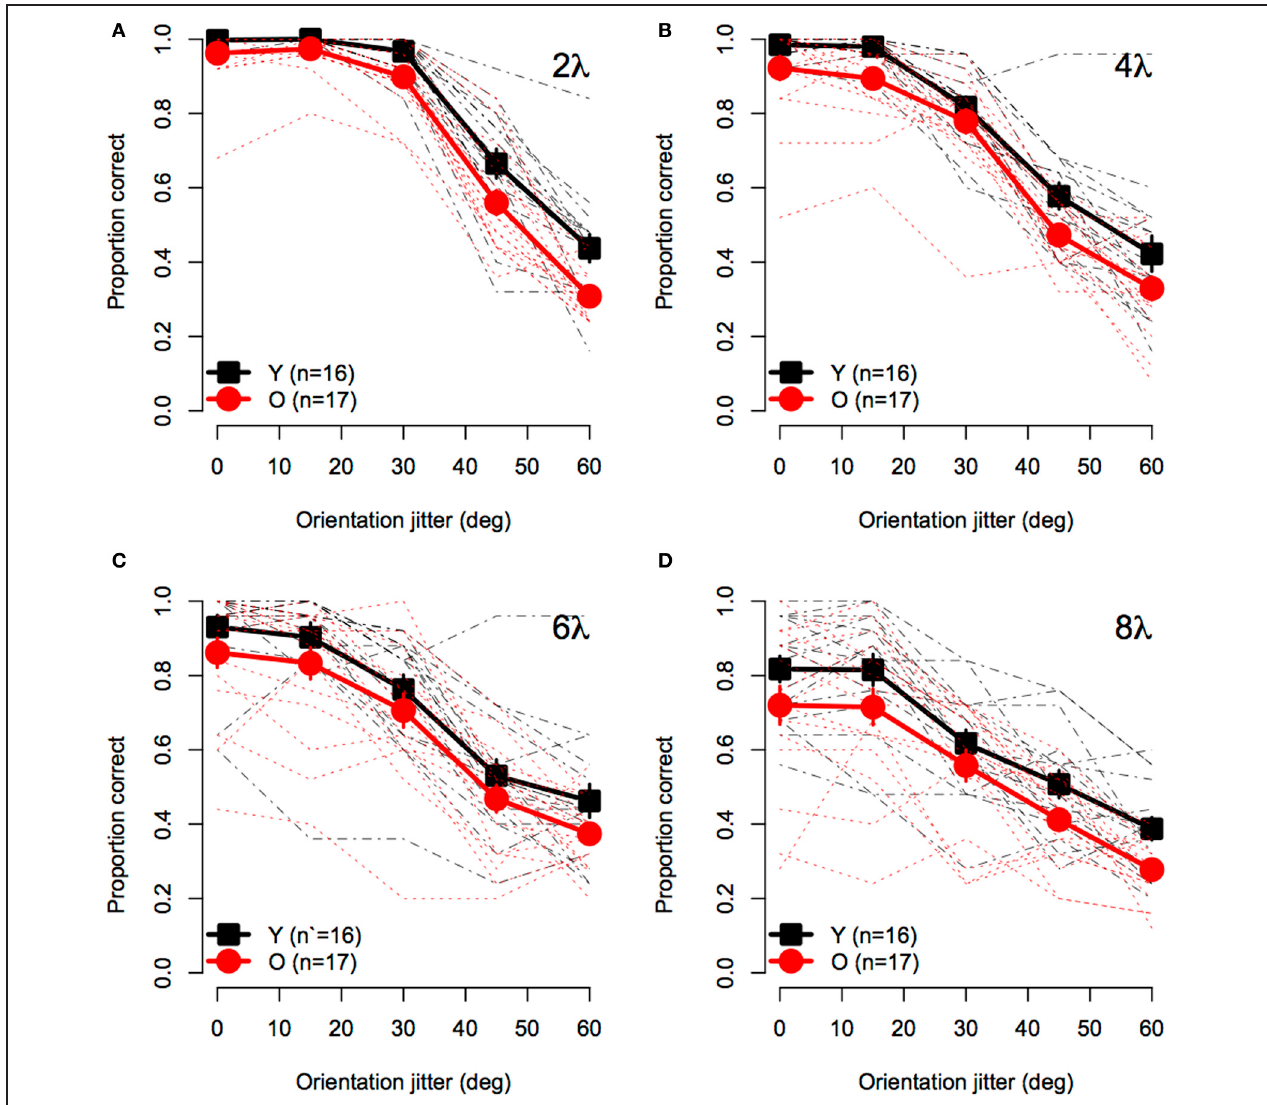
FIGURE 2 | Experiment 1 results: Contour discrimination accuracy is shown as a function of contour element orientation jitter for four inter-element spacing conditions (A–D). Black squares show mean